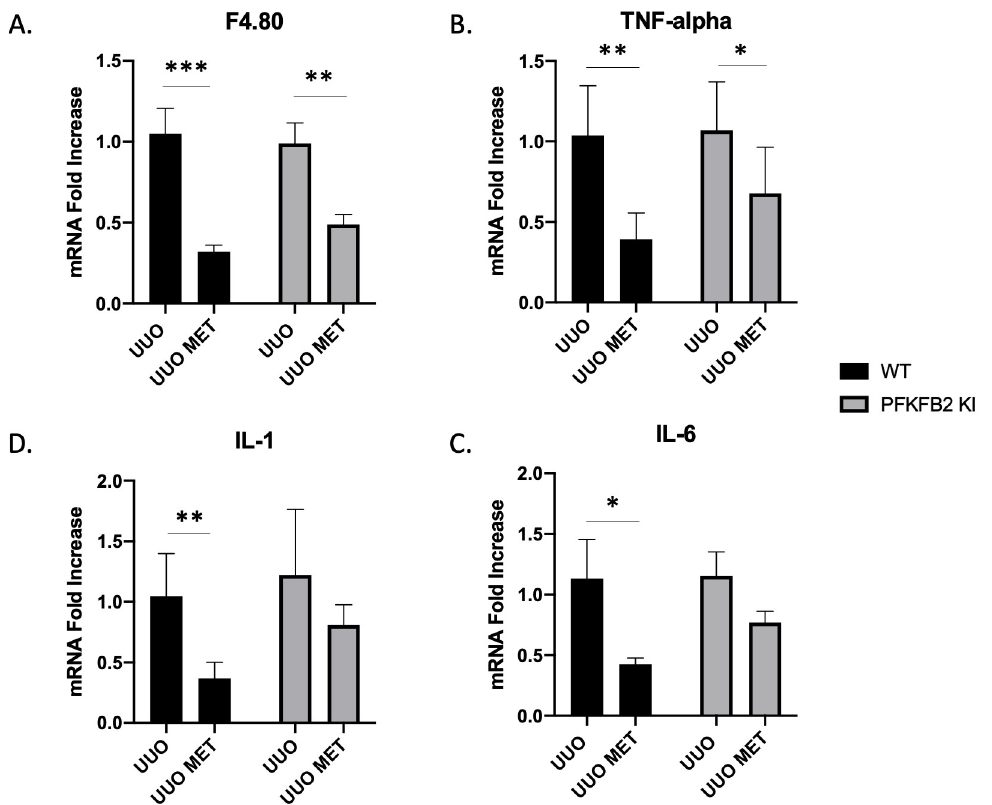
Fig 5. Measurement of markers of inflammation via RT-PCR in WT and PFKFB2 KI kidneys subjected to UUO ± metformin (A-D). mRNA expression of F4.80, TNF- α , Interleukin-1 (IL-1) and Interleukin-6 (IL-6) was significantly reduced with the addition of metformin in wild-type mice ( A-D ��� p = 0.0001, �� p = 0.0016, � p = 0.0230, �� p = 0.0008 respectively). In the PFKFB2 KI mice, there was decreased mRNA expression of F4.80 and TNF- α with the addition of metformin ( A, B �� p = 0.0024, � p = 0.0277 respectively). There was no significance difference between WT and PFKFB2 KI mouse groups in any of these parameters measured. Mean + SD.